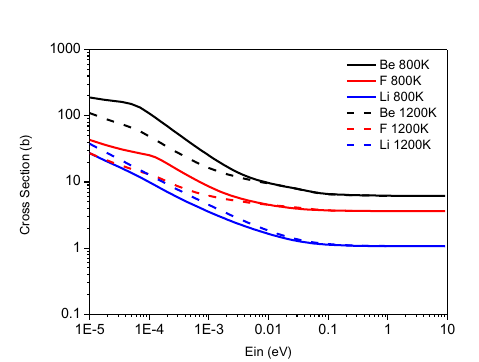
Fig. 10. Thermal neutron scattering cross sections for F, Li, Be at 800K and